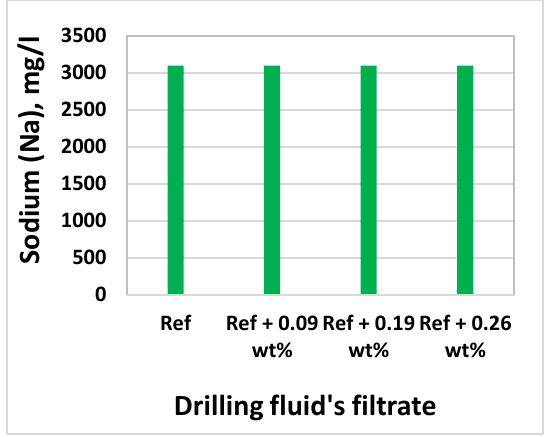
Figure 17. Na in the filtrates of drilling fluids.